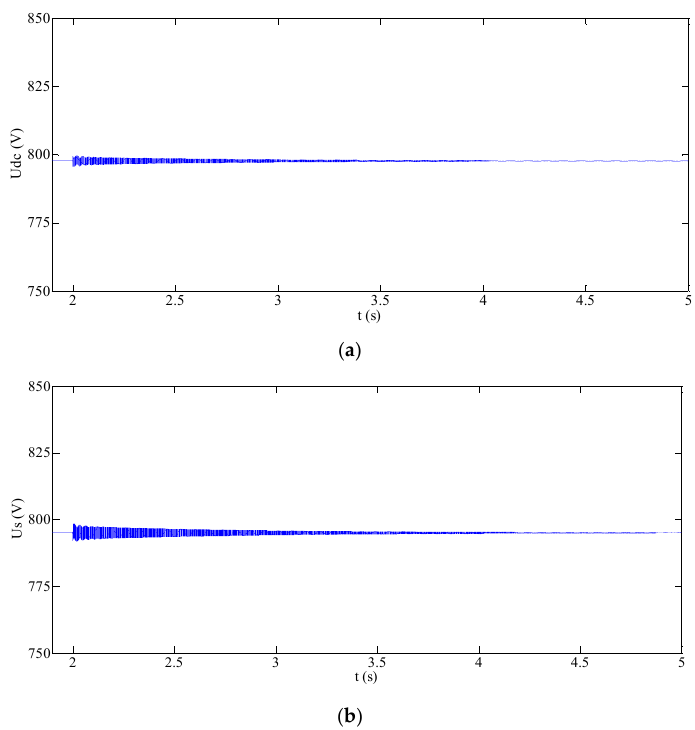
Figure 5. The simulation result when P s changes from 90kW to 95kW: ( a ) The DC bus voltage; ( b ) The DC-side voltage of VSC2.